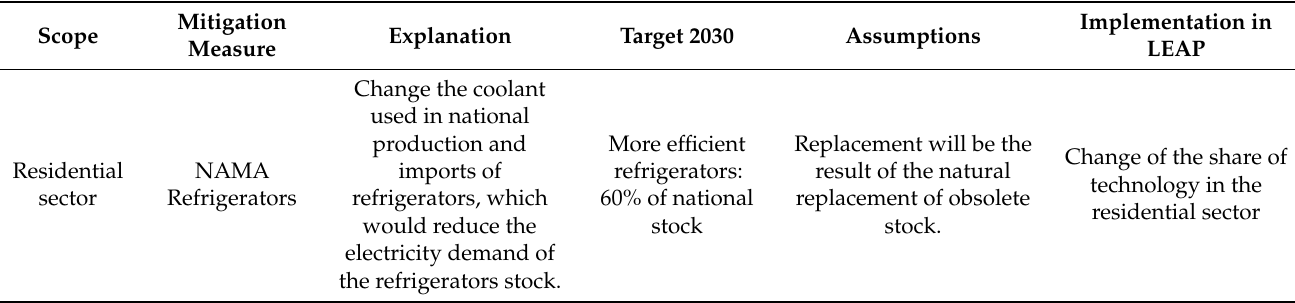
Table A3. Mitigation actions of the energy sector included in the mitigation